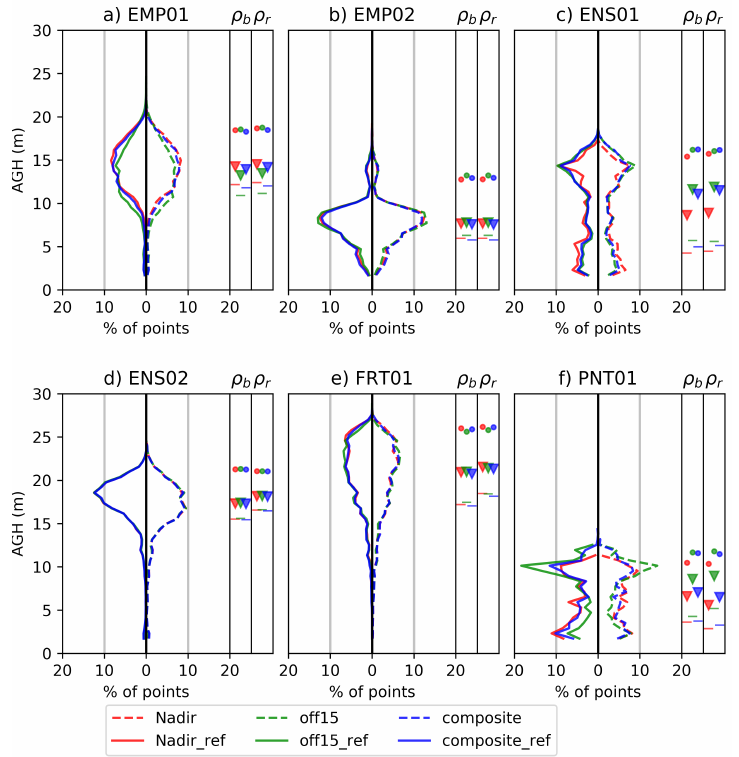
Figure 3. Vertical distribution of points above ground height at each site. The solid lines to the left show the distribution of Above Ground Height (AGH) calculated using the reference ground points and the dashed lines to the right show the distribution of AGH calculated using the manually defined ground points. The AGH 95th (dots), 50th (triangles) and 25th (dashes) percentiles for the reference distribution ( ρ r ) and manual ground distributions are given in the two side